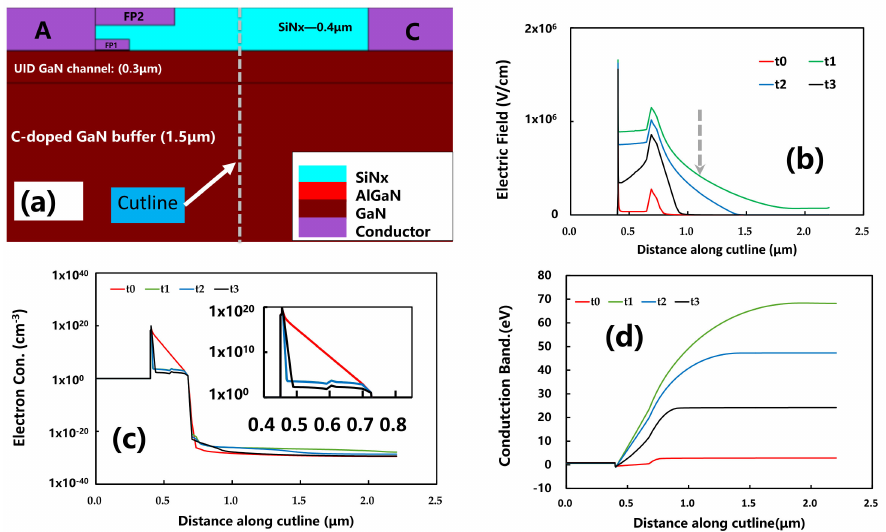
Figure 10. Schematic of ( a ) the cutline location; ( b ) the electric field at different timings; ( c ) the electron concentration in the channel region at different timings; and ( d ) the conduction band energy at different